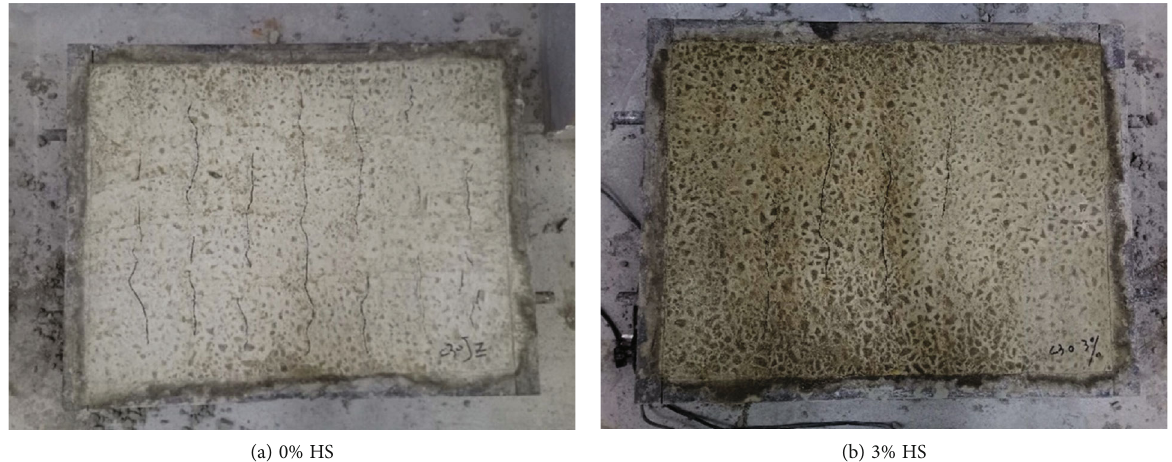
Figure 4: Distribution of fi ssures after 24 h. Table 2: Results of the early-age anticracking